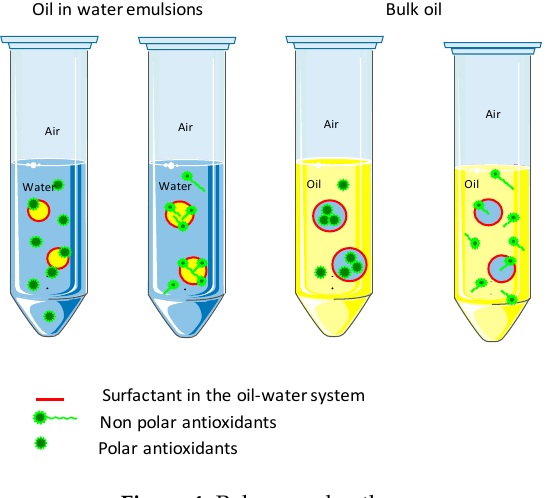
Figure 4. Polar paradox theory.